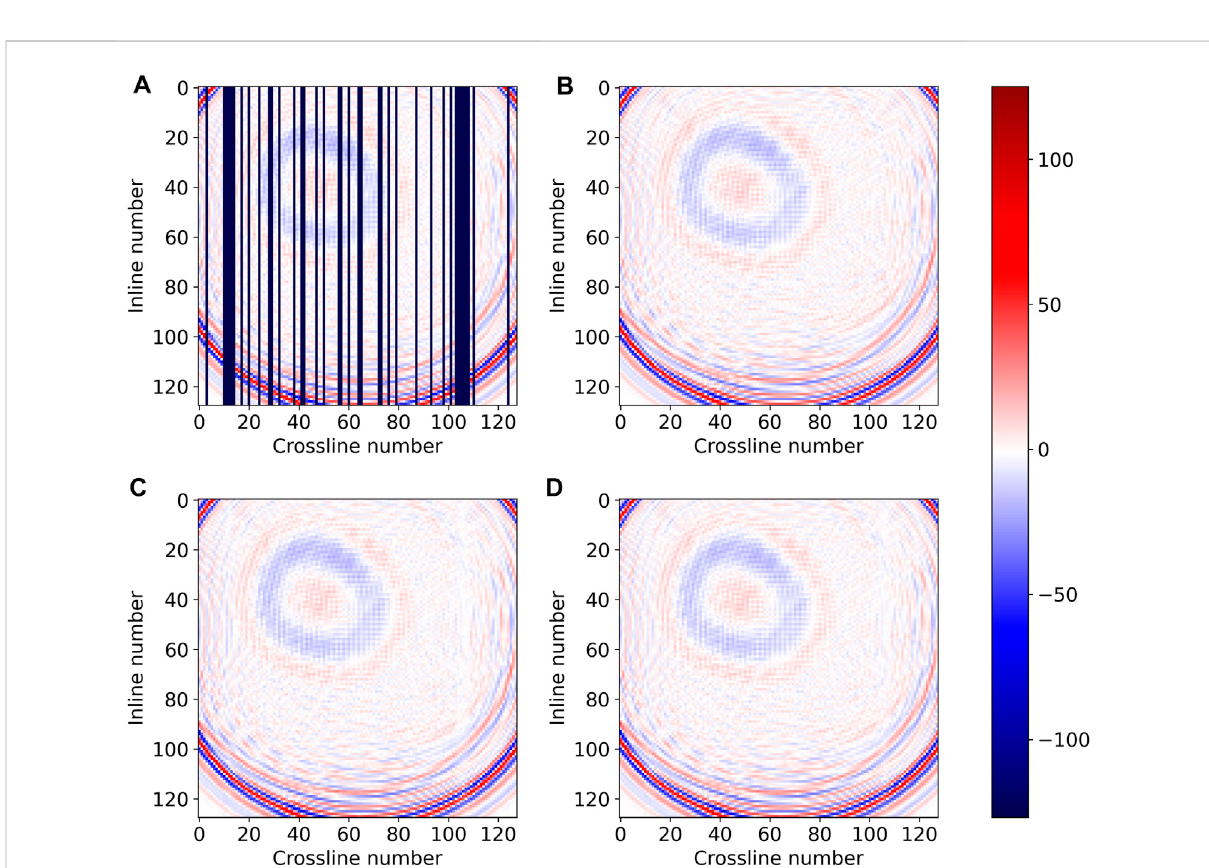
FIGURE 6 TimesliceofinterpolationresultsontheSEGC3syntheticdata: (A) missingtracesdata; (B) groundtruth; (C) Unet(Chaietal.,2021);and (D) DS- Unet.